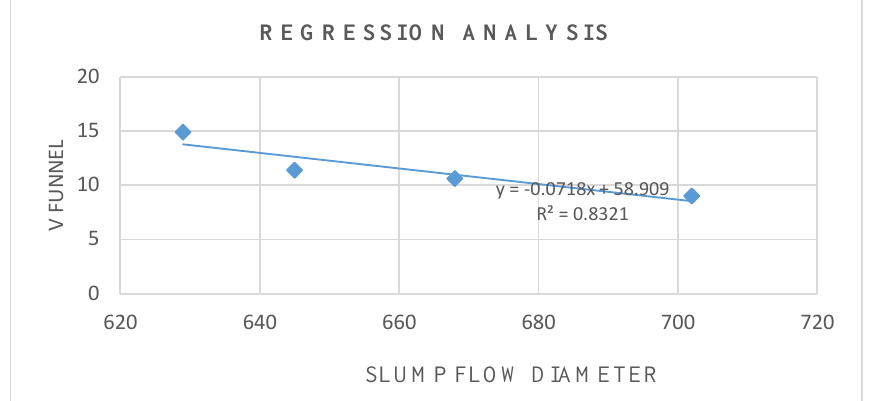
Fig. 14. Regression Analysis Slump Flow vs V funnel.